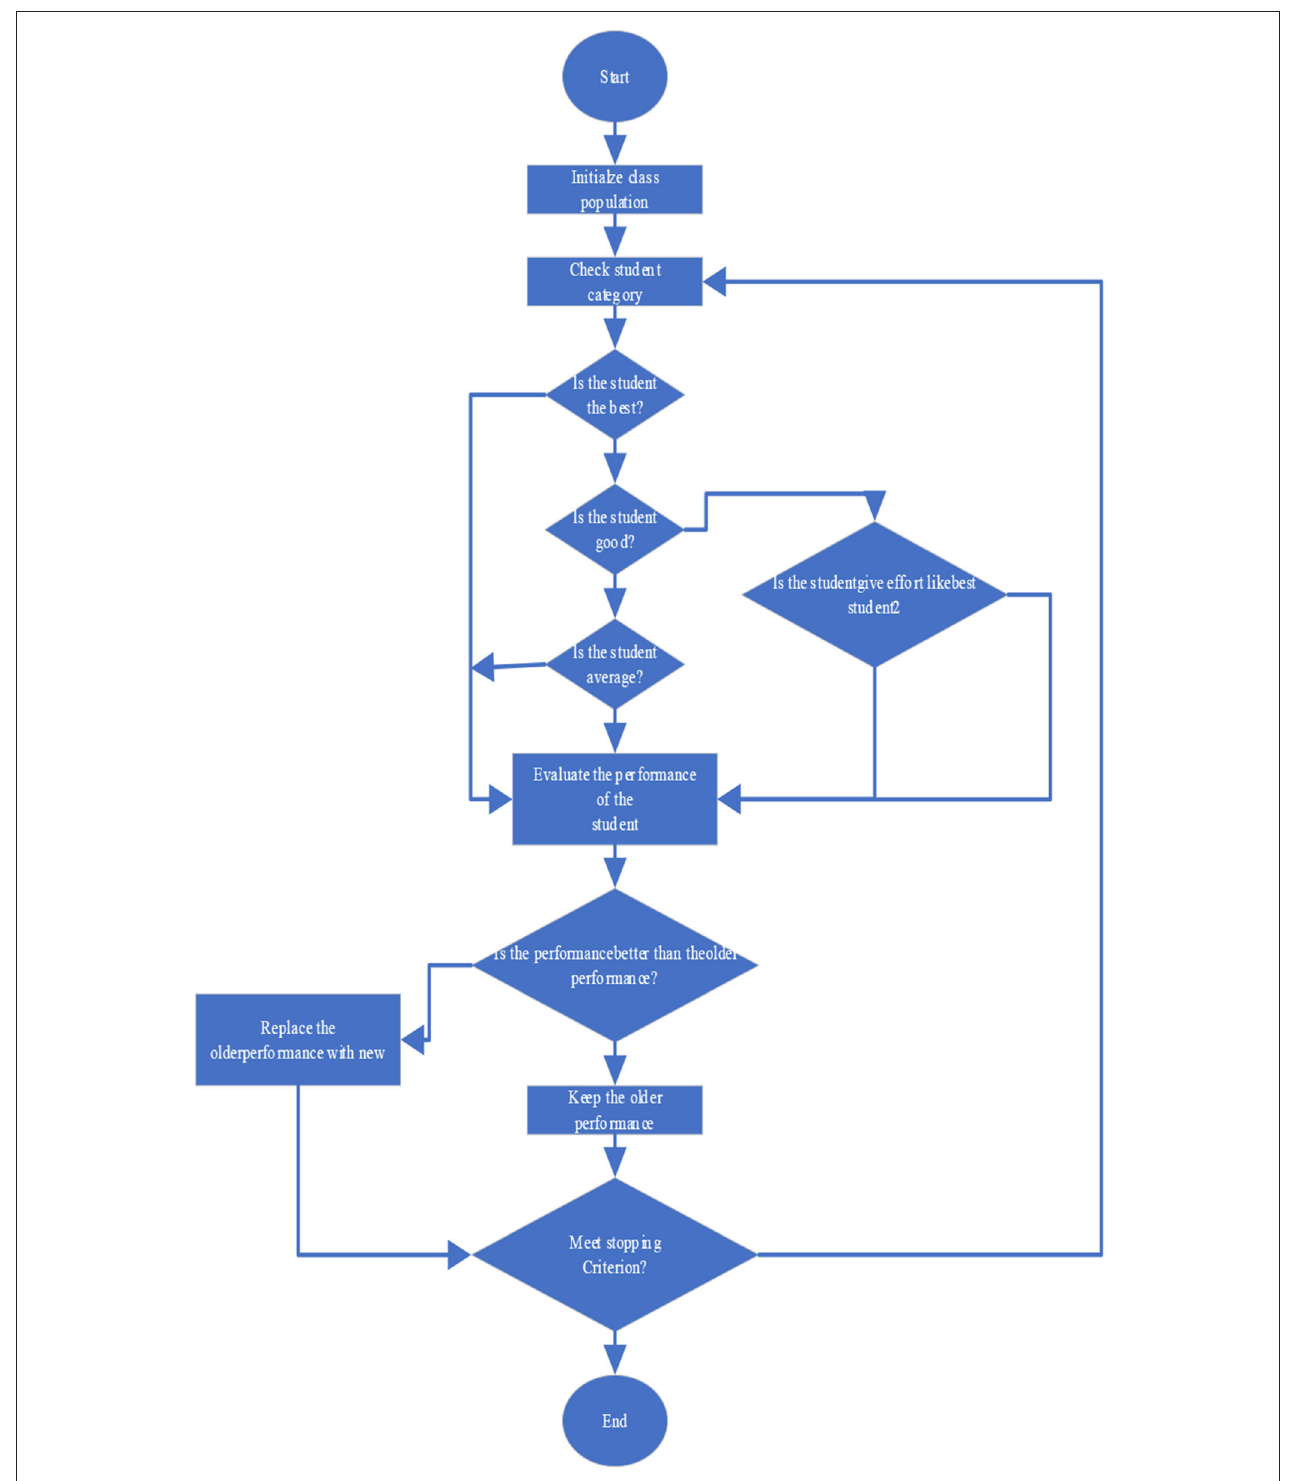
FIGURE 1 | Overall algorithm flow